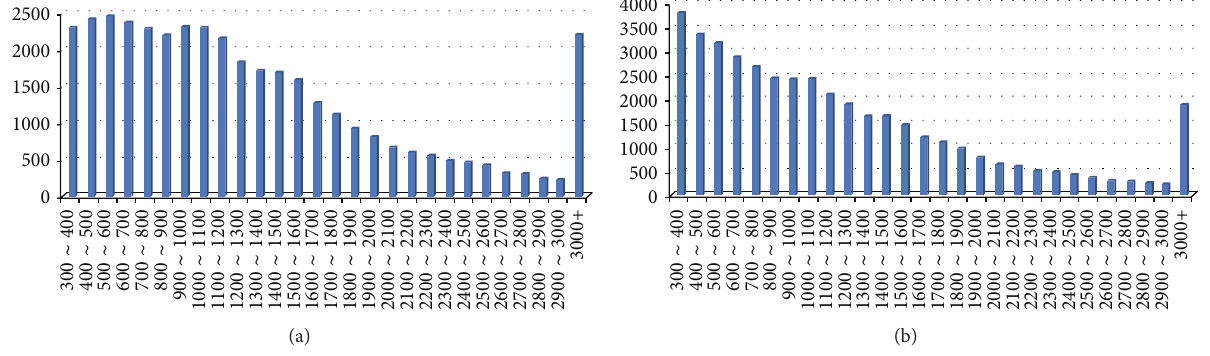
Figure 3: The size distribution of transcriptomic unigenes assembled by the B. rapa (a) and B. oleracea (b).